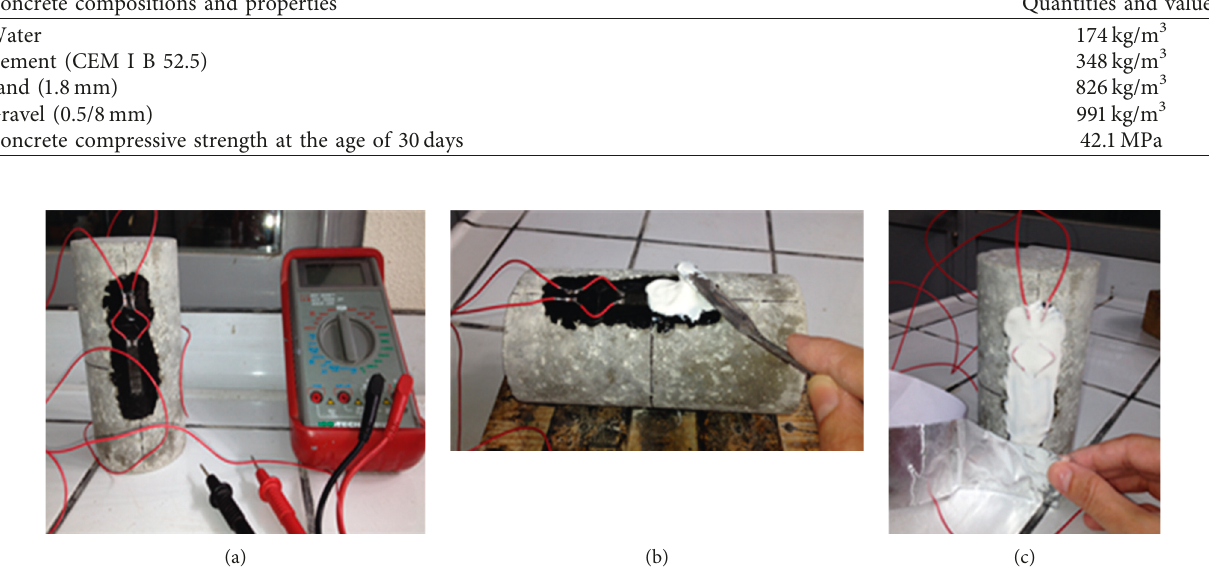
Figure 1: (a) Setting the wires and verifying conductivity by using a multimeter, (b) applying the CAF4 paste, and (c) covering the specimen with an aluminium scotch tape.